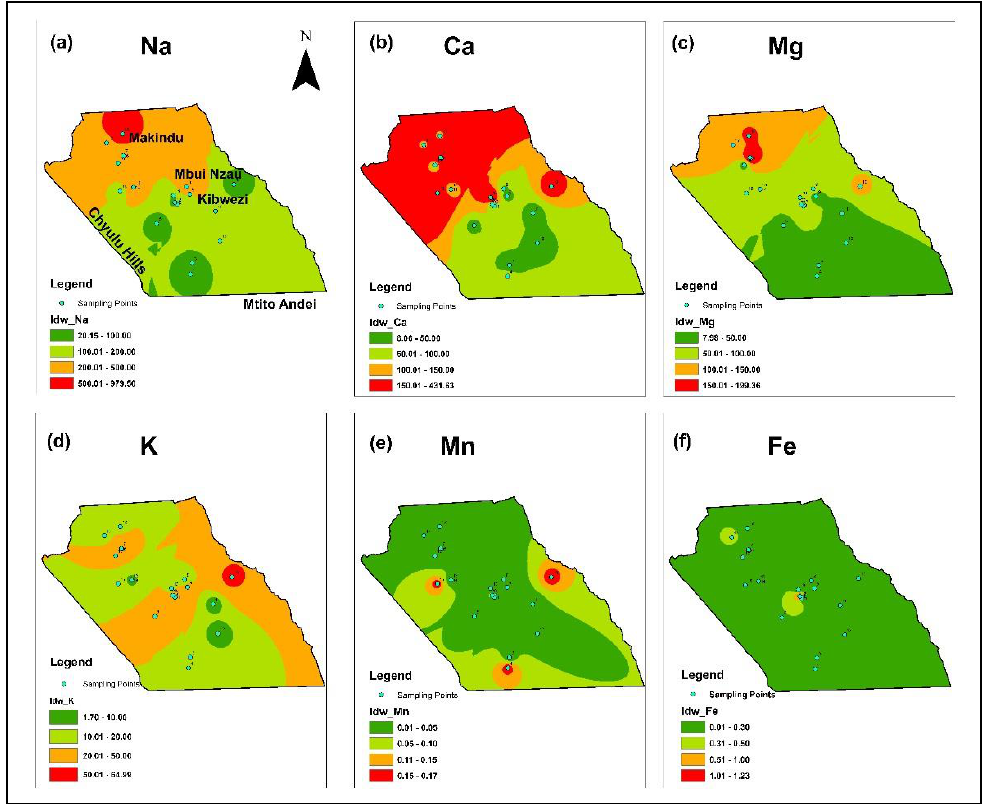
Figure 3. Spatial variation of Na ( a ), Ca ( b ), Mg ( c ), K ( d ), Mn ( e ), and Fe ( f ) in groundwater in Makueni County in November 2018 where, areas in red exceed the recommended limits for drinking water of these cations.